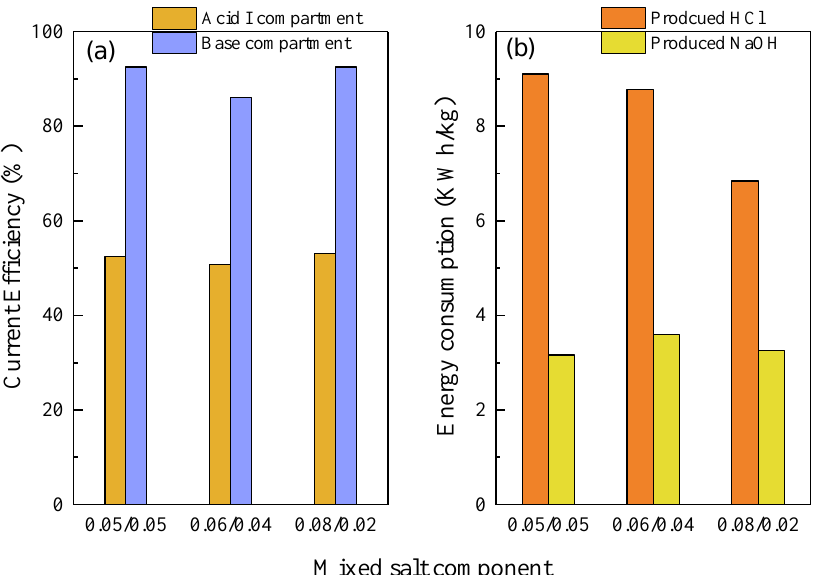
Figure 7. The influence of the mixed salt component on the current e ffi ciency and energy consumption. ( a ) Current e ffi ciency in the acid I and base compartment for the di ff erent salt components; ( b ) energy consumption for the produced HCl and NaOH.